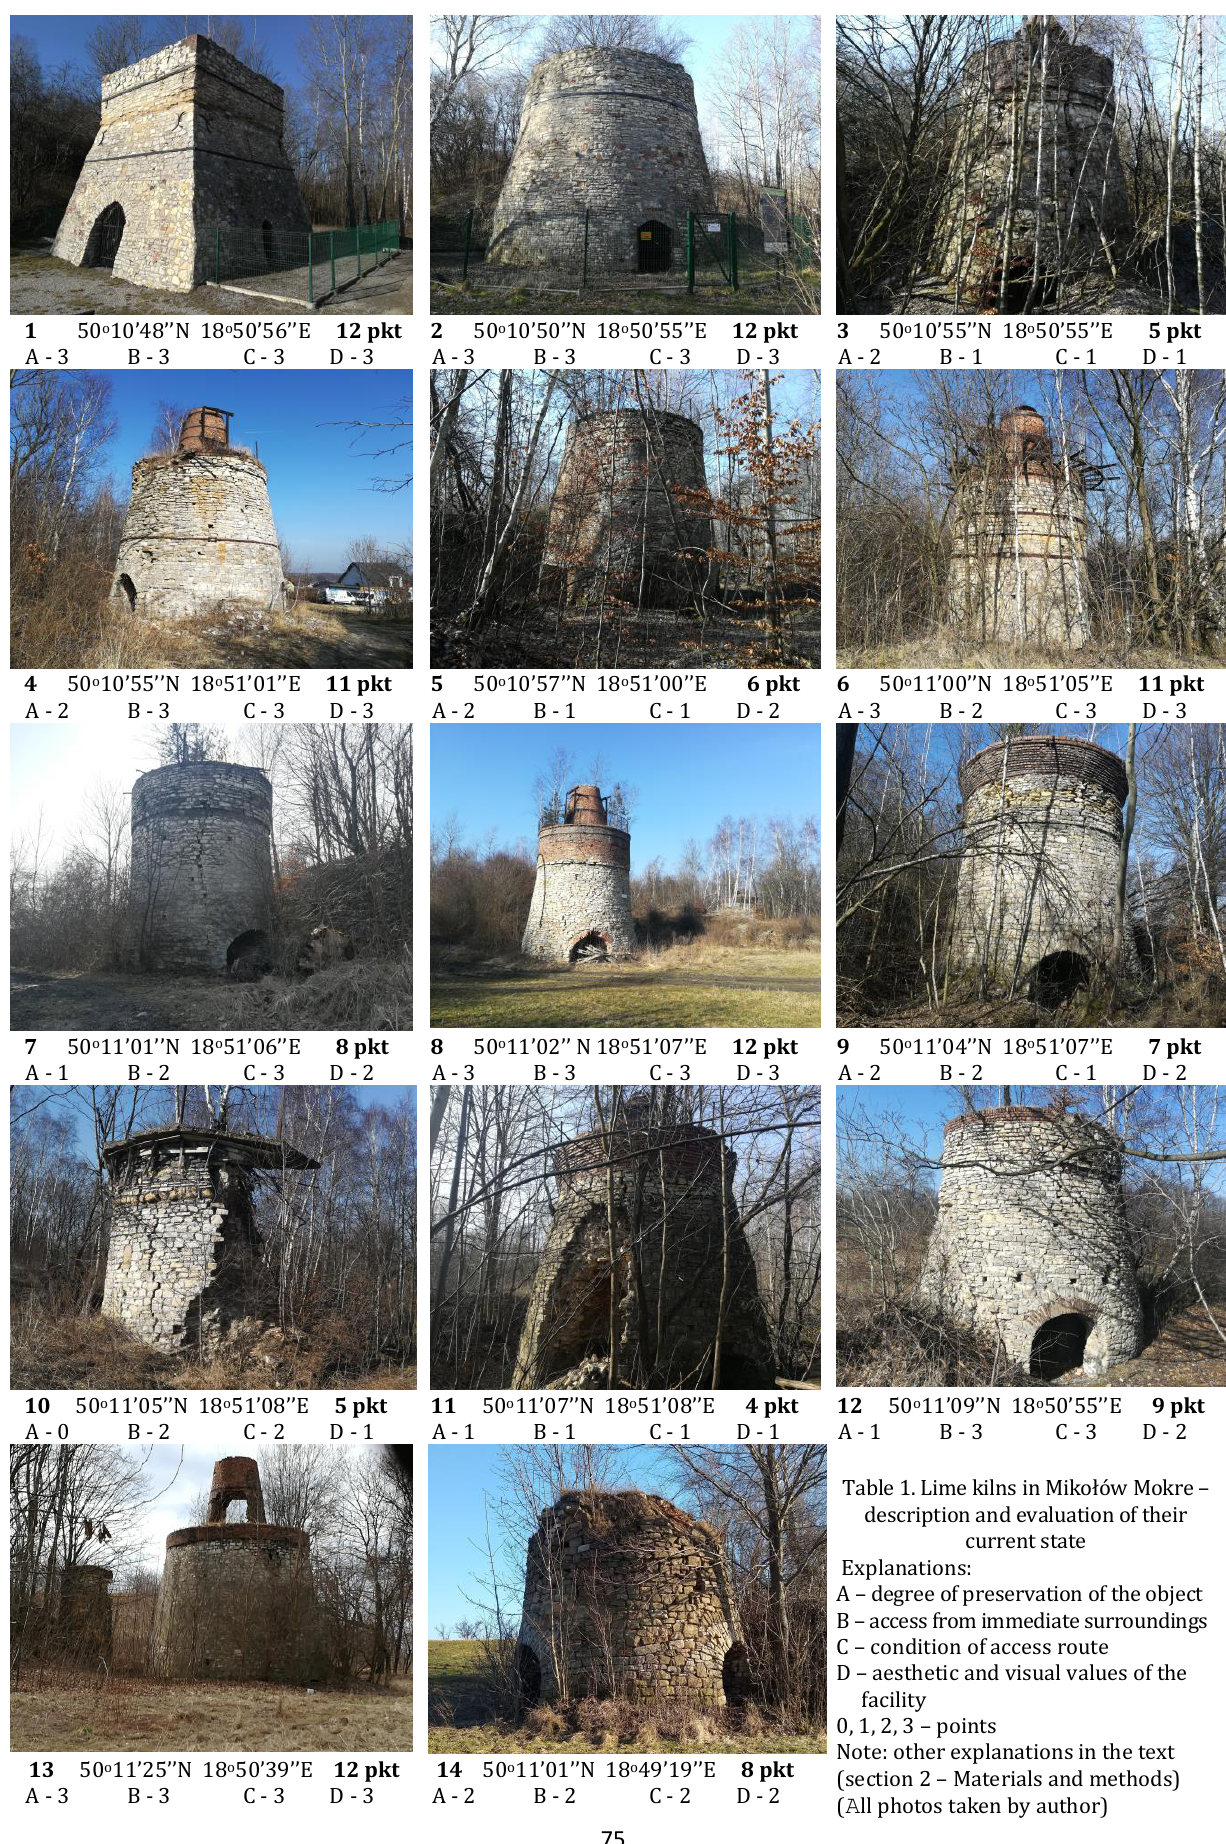
Table 1. Lime kilns in Mikołów Mokre